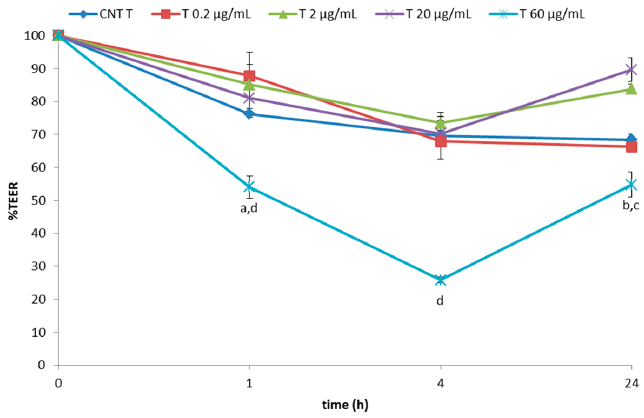
Figure 4. Effects of in vitro digested tomatine spiked to tomato matrix (T) on Caco-2 TEER values expressed as % relative to the control (TC). Values represent mean ± standard deviation of three different biological replications and two technical repetitions. Different superscript letters indicate statistically significant differences ( p < 0.05) in adhesion as assessed by one-way ANOVA test.